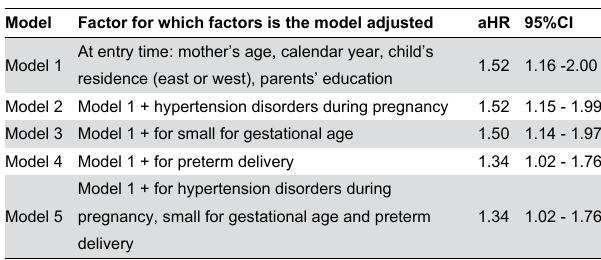
Table 3. Hazard ratio (HR) for cardiovascular disease diagnoses in mothers of a male CP child with different adjustment